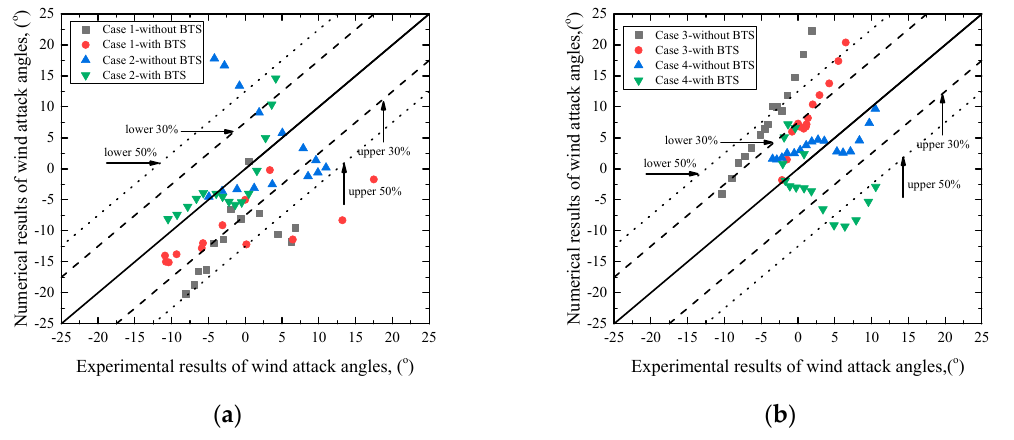
Figure 16. Numerical results vs. experimental results of wind attack angles at main deck level under different cases. ( a ) Case 1 and 2; ( b ) Case 3 and 4.